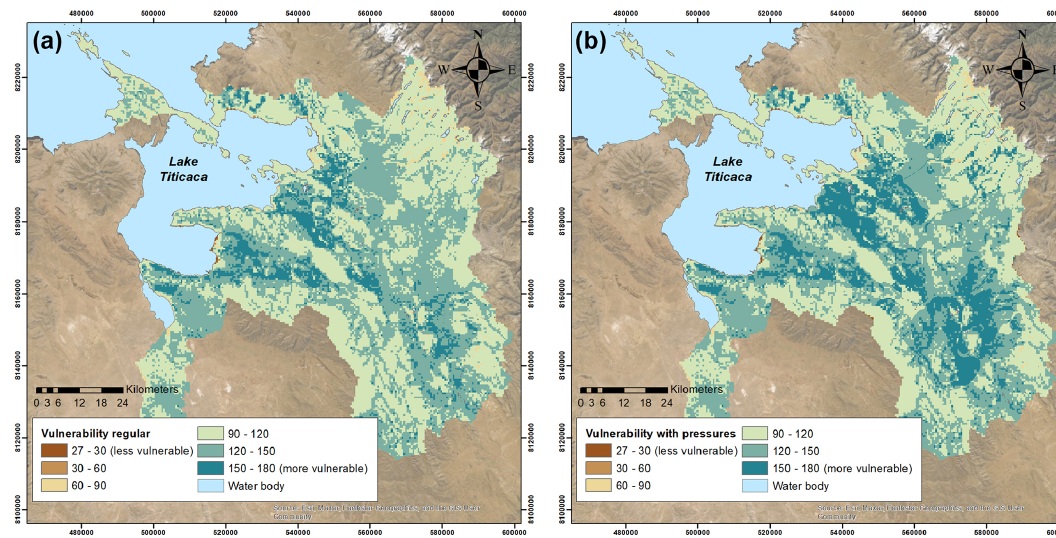
Figure 5. Vulnerability results considering common DRASTIC method (a) and considering anthropic pressures (b)